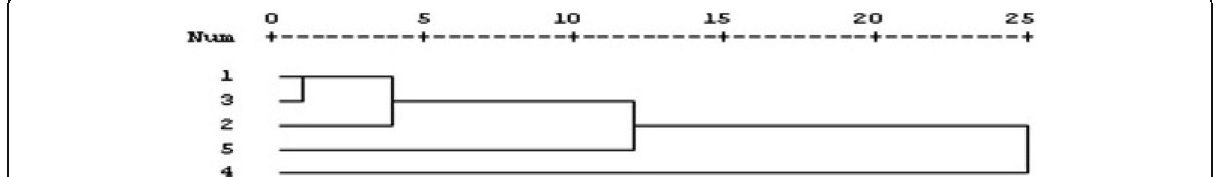
Fig. 3 Dendrogram illustrating genetic distance between the five cultivars of Coleus based on ISSR